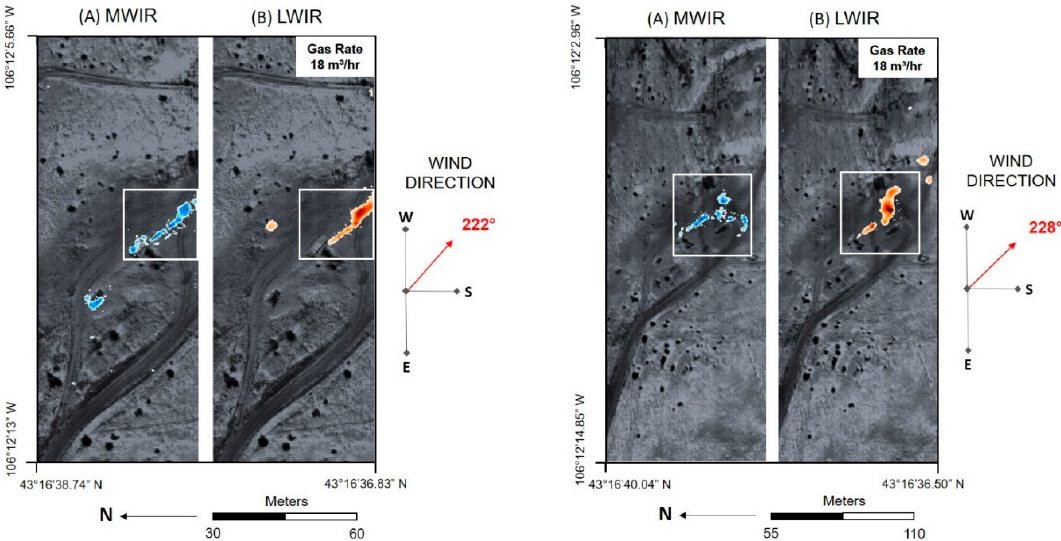
Figure 6. Detection of CH 4 plumes in the ( A ) MWIR and ( B ) LWIR ranges—SEBASS flight performed on 20th August 2010 over station 44-MX-10 (gas source: RMOTC—injection) at (1) 11:07:59 (local time) with 0.50 m spatial resolution and at 457 m AGL and (2) 13:08:18 (local time) with 0.84 m spatial resolution and at 762 m AGL. The red square indicates the ground station location (i.e., source of the gas leak) and respective plume. Pixels in blue ( A ) and red ( B ) indicate the occurrence of methane in the scene. The main direction of the wind is displayed in the diagram on the right side of the figure (data collected between (1) 10:30 p.m.–11:30 p.m. and (2) 12:30 p.m.–13:30 p.m.).